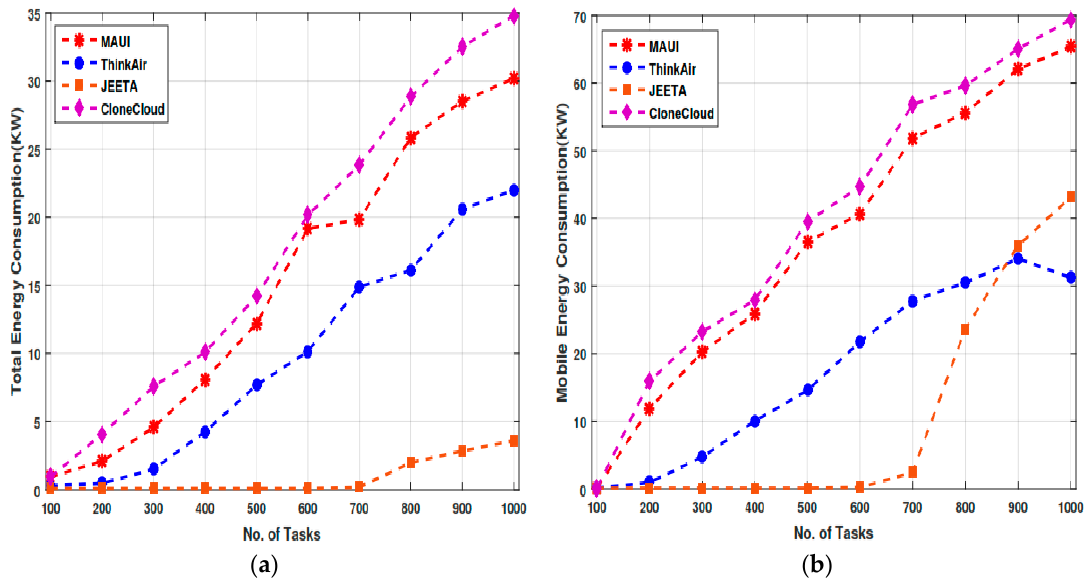
Figure 8. Augmented application performance. ( a ) Without mobility; ( b ) with mobility.